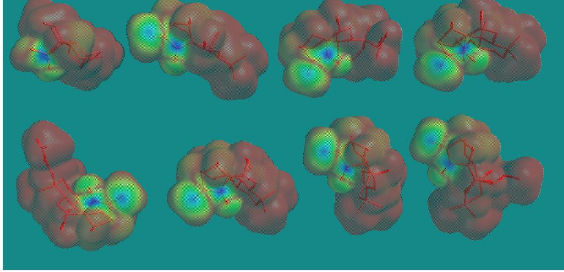
Figure 5. LUMO density map (from L-R: L,